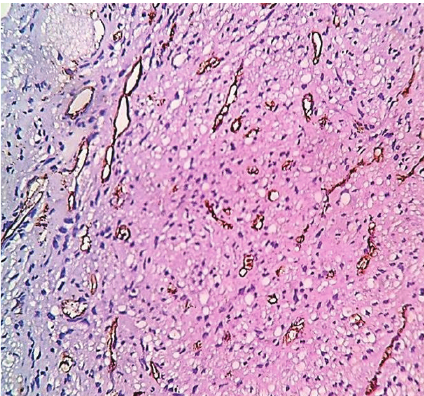
Figure 6: Lesional cells are negative for CD34. Positive stain highlights the extensive vascular network of the lesion (original magnification ×